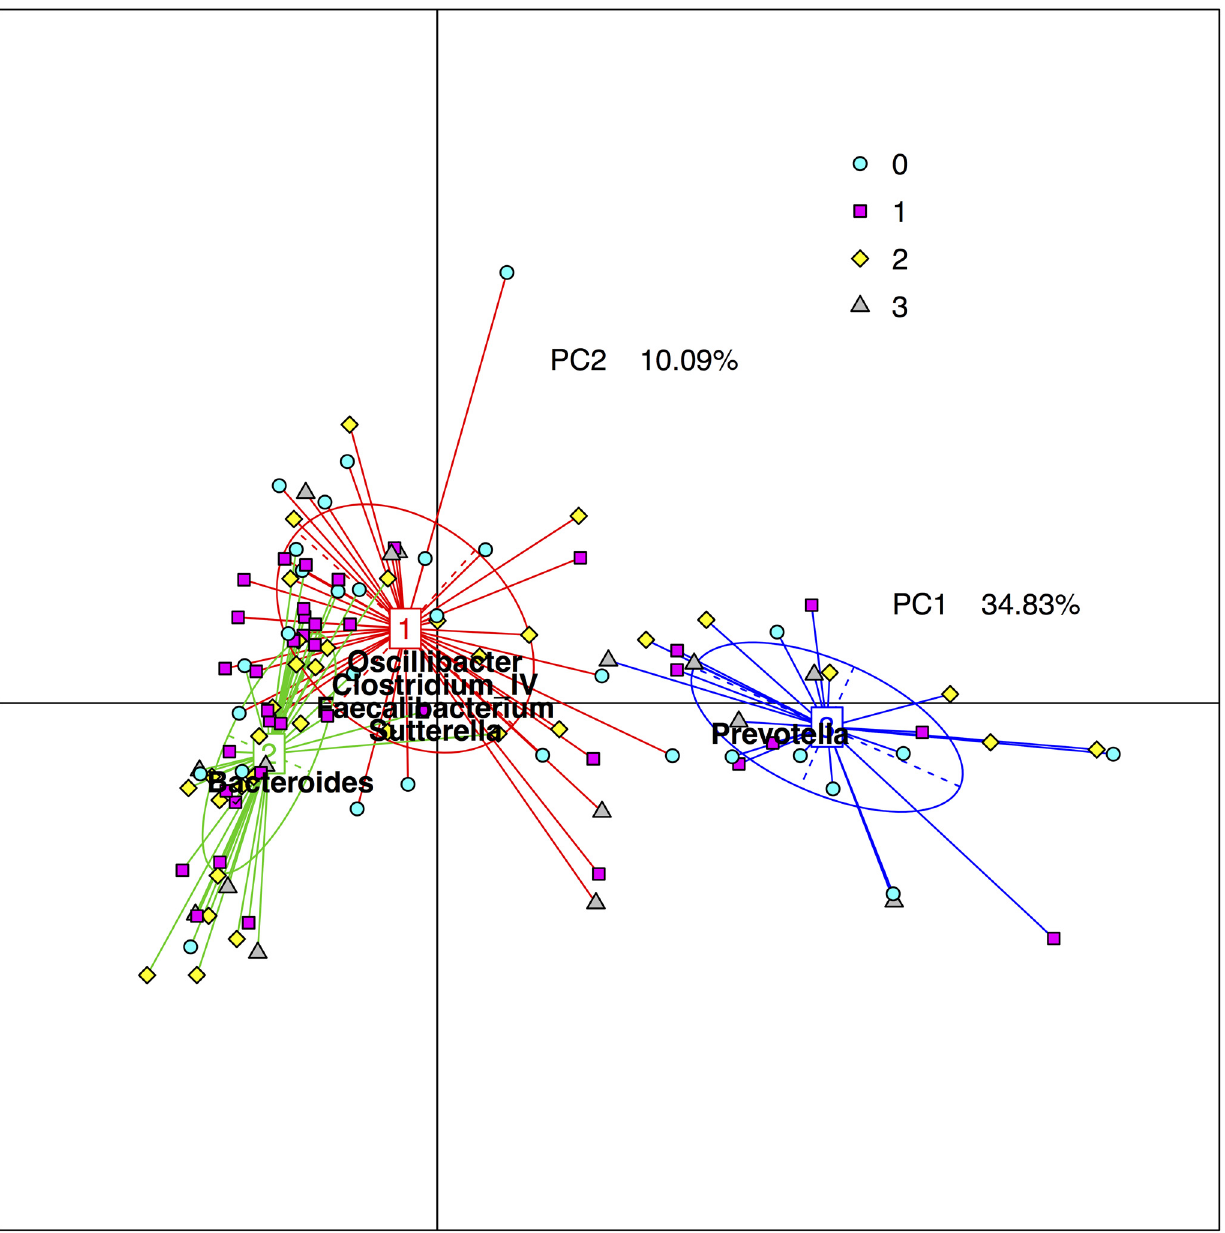
Fig 3. Enterotype groups according to ancestral HLA haplotype AH8.1 status. The figure shows the individual samples as colored symbols according to their HLA genotype groups (see below) distributed according to similarity of their distribution of bacterial genera in a two-dimensional plot according to the methods by Arumugam et al. [34]. The samples were classified into three fractions, enterotypes, dominated by either Prevotella (blue), Bacteroides (green) or a mix of bacteria (red), where the colored square indicate the centre of the distribution of the enterotype, the straight lines connect the included samples and the colored ellipses cover the individuals near the center of gravity for each cluster (1.5 σ ). Bacterial taxa overrepresented in the corresponding enterotypes are listed. As evident from the symbol color of the individual dots, the different HLA genotype groups (see below) were not preferentially distributed to one particular enterotype fraction. Yellow diamonds : AH8.1 homozygotes, i.e. homozygosity for both HLA-B * 08 and HLA-DRB1 * 03. Violet squares : AH8.1 heterozygous, i.e. at least 1 copy of HLA-B * 08 and HLA-DRB1 * 03. Turquoise circles : Non AH8.1 heterozygotes, i.e. HLA-B * 08 and HLA-DRB1 * 03 both not present. Grey triangles : HLA-DRB1 homozygotes but non AH8.1.